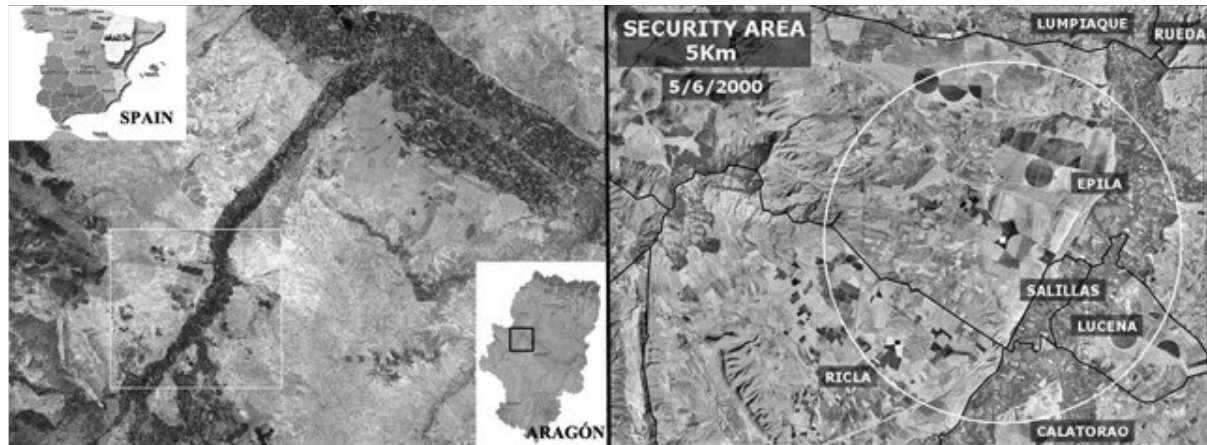
Figure 1. Jalón river area of Zaragoza (Spain) where fire blight was detected (left) (the expanded area to the right is indi - cated in the Aragón map at left by a square), and detail of the first infected orchard identified and 5 km radius Security Area initially established